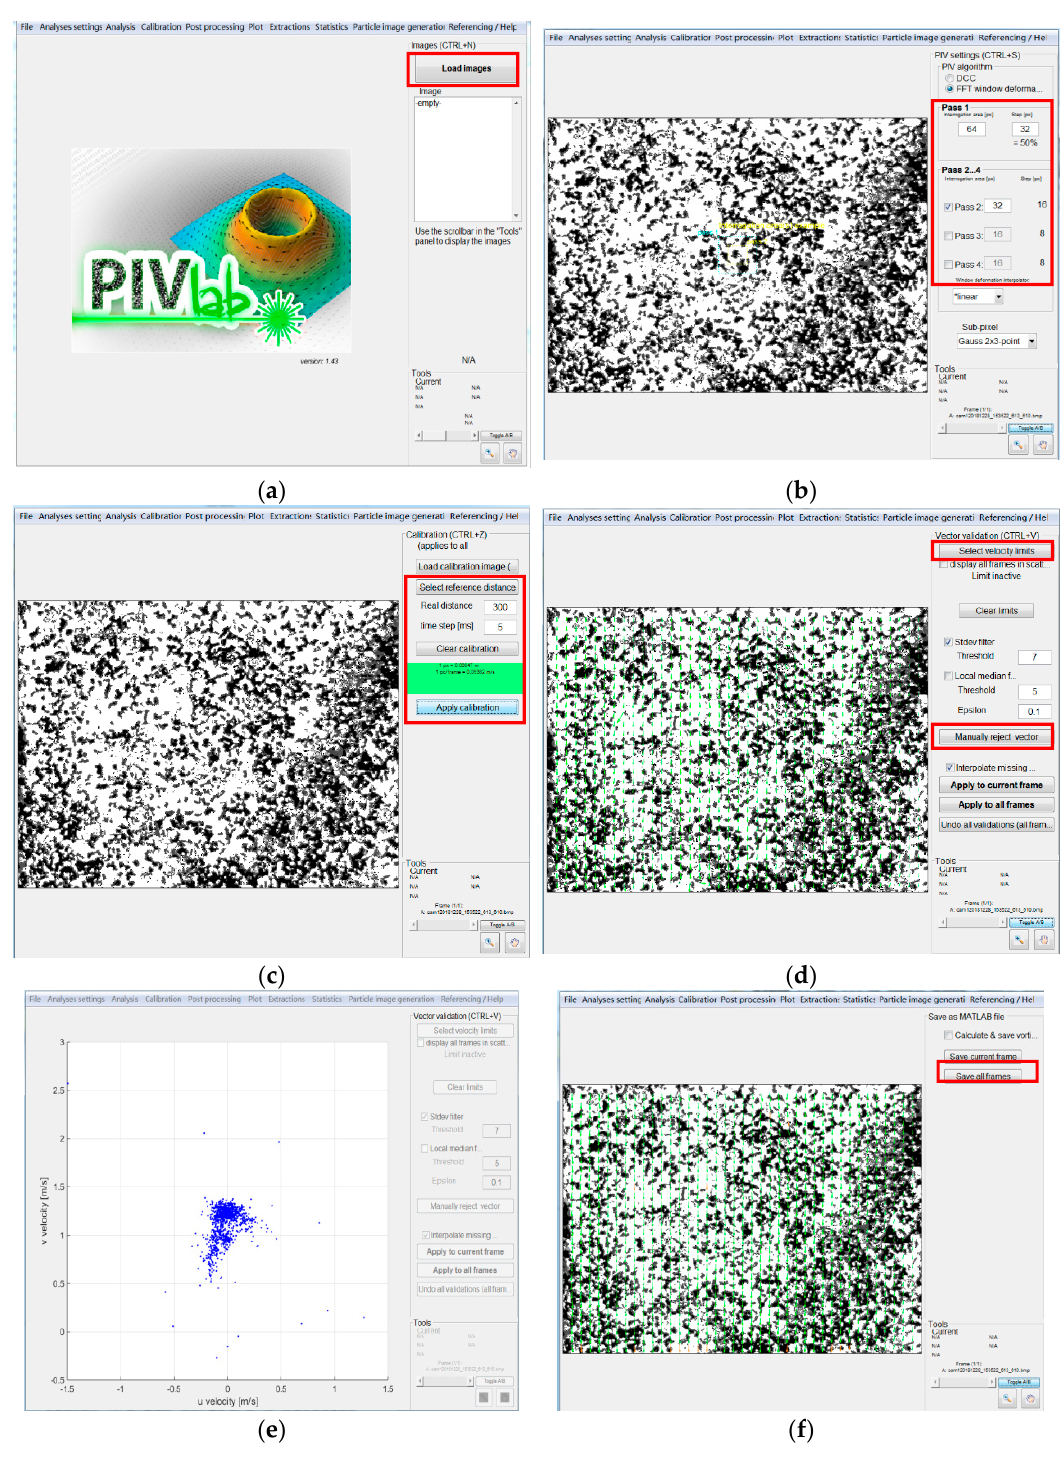
Figure 14. Procedure for particle image processing. ( a ) Image import; ( b ) window selection; ( c ) coordinate transformation; ( d ) local correction; ( e ) velocity range limit; ( f ) velocity vector output.